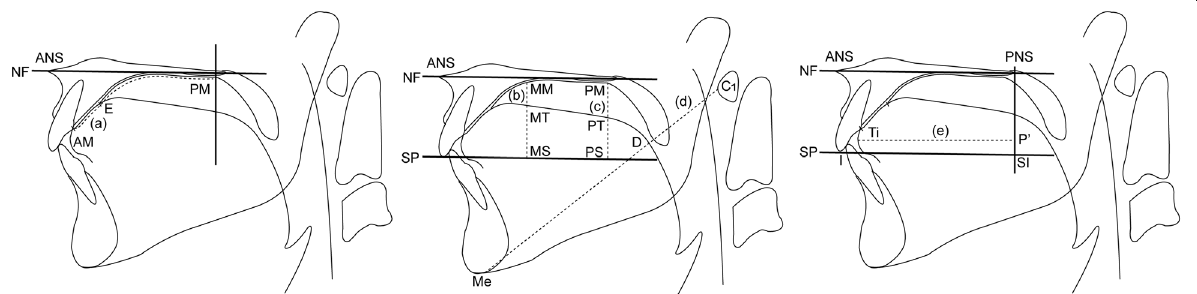
Fig. 6 Linear measurements. (a) Contact of the tongue and palate, AM-E/AM-PM. (b) Front part of the dorsal tongue, MM-MT/MM-MS. (c) Mid part of the dorsal tongue, PM-PT/PM-PS. (d) Rear part of the dorsal tongue, C1-D/C1-Me. (e) Tongue tip, P ′ -Ti/SI-I. MM-MT, MM-MS, PM-PT, PM-PS, C1-D, C1-Me, and SI-I are distances measured in a straight line. P ′ -Ti is the shortest distance from a line perpendicular to the palatal plane (through the PNS) to Ti (modified from Fujiki et al. [14]). For abbreviations, see Table 1